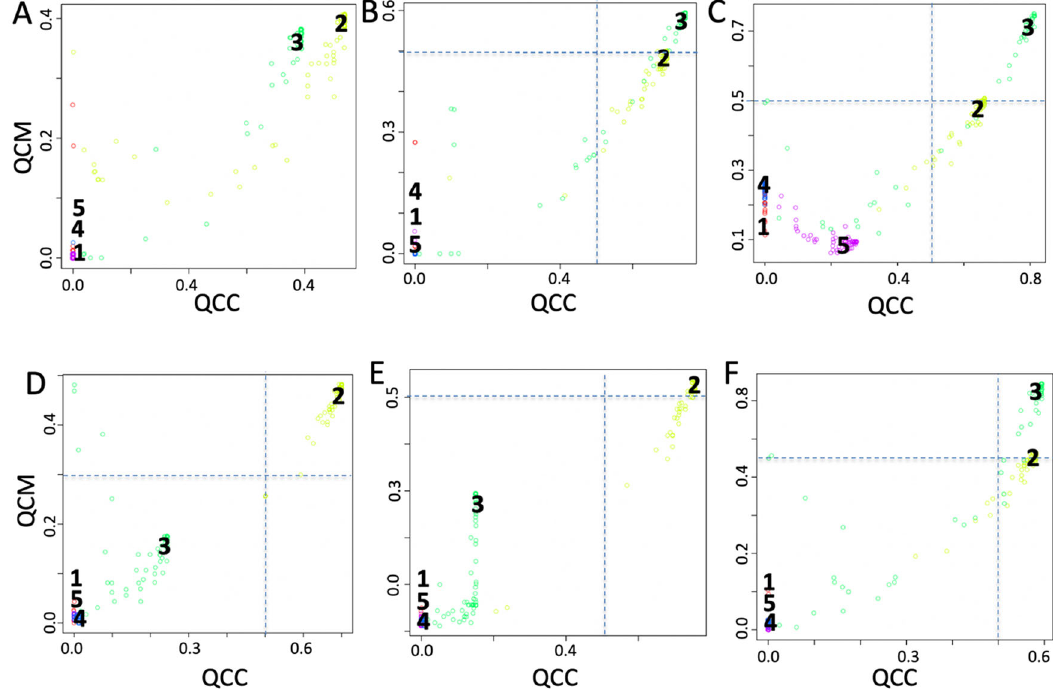
Fig. 4 QCM/QCC plots using different normalizations for the SCA input counts table. a Log10 transformed, ( b ) Centered log-ratio normalization (CLR), ( c ) relative log-expression (RLE), ( d ) full-quantile normalization (FQ), ( e ) sum scaling normalization (SUM), ( f ) weighted trimmed mean of M-values